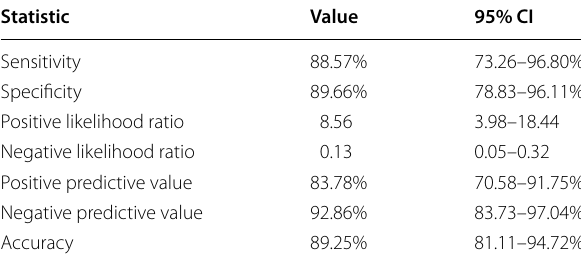
Table 8 showing the accuracy measures of the combination of both methods (1 and